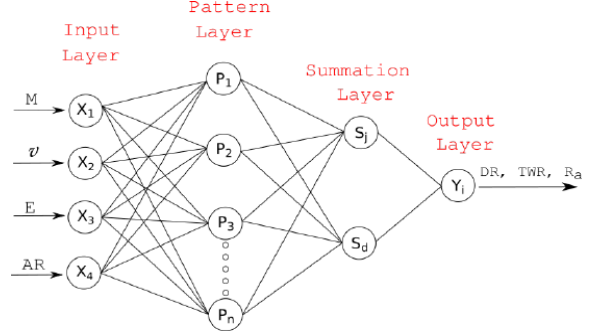
Figure 4. GRNN architecture.